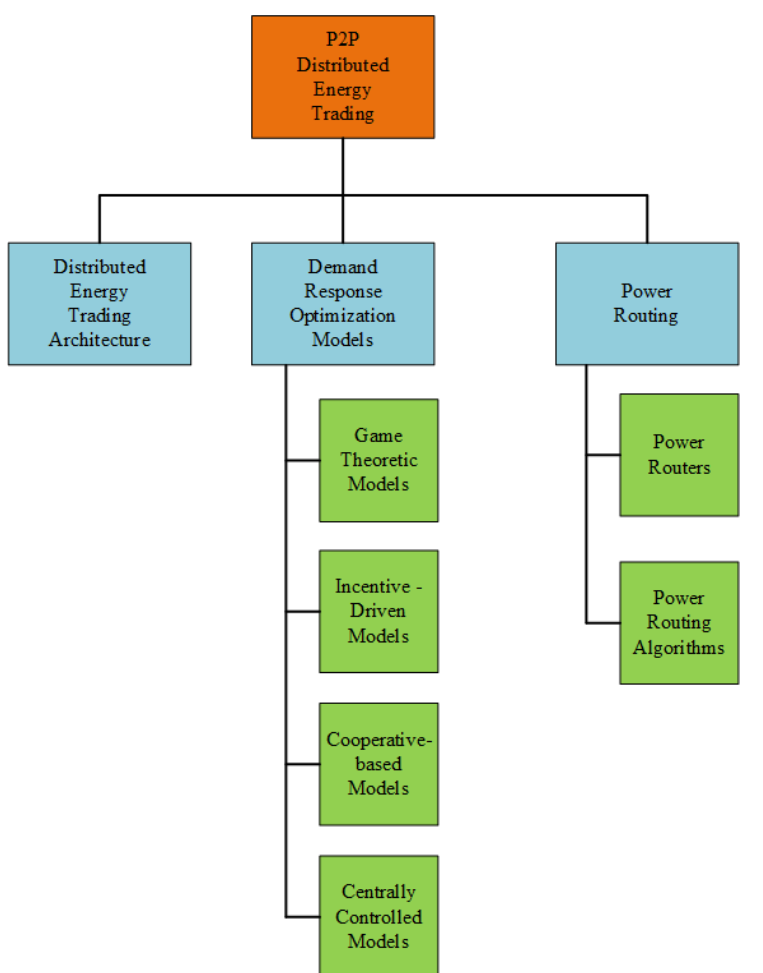
Figure 1. Classification Diagram.